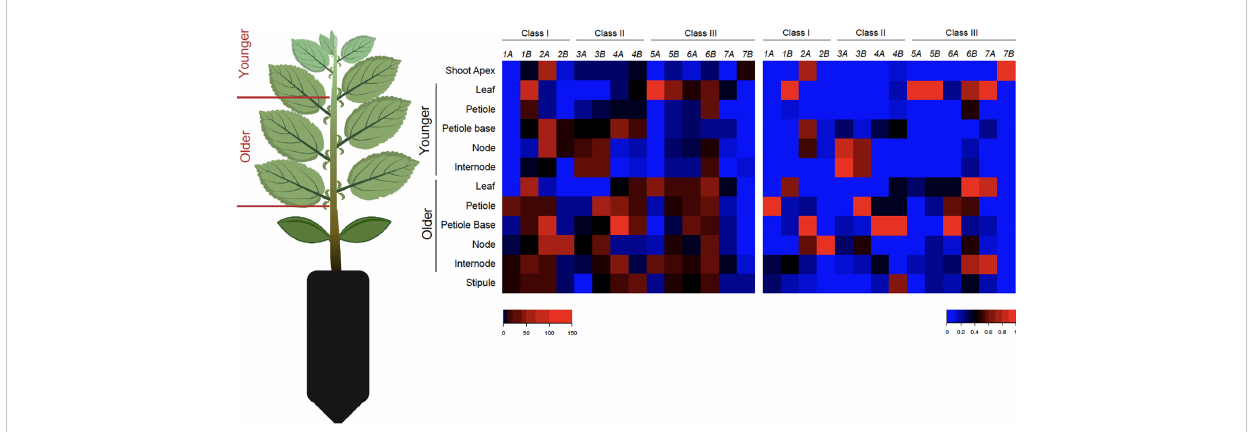
FIGURE 5 Expression pro fi les of MdGA2ox genes in apple seedling structures. Seedlings were partitioned into two general sections, Younger, comprising all structures apical to the most apical fully expanded leaf and Older, comprising this leaf and all basipetal structures. Younger and older stipules were pooled. The heat map on the left represents expression values derived from quantitative PCR and relative to an apple ACTIN gene. The heat map on the right represents expression values relative to the strongest expression for each gene among structures. Color keys at the bottom indicate expression levels from low/least (blue) to high/greatest